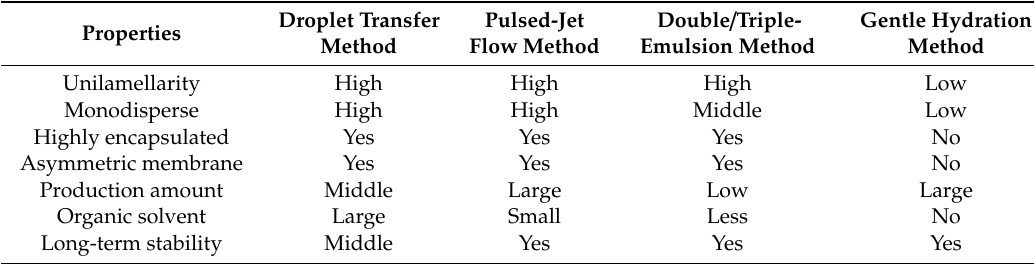
Table 1. Summary of the giant lipid vesicle